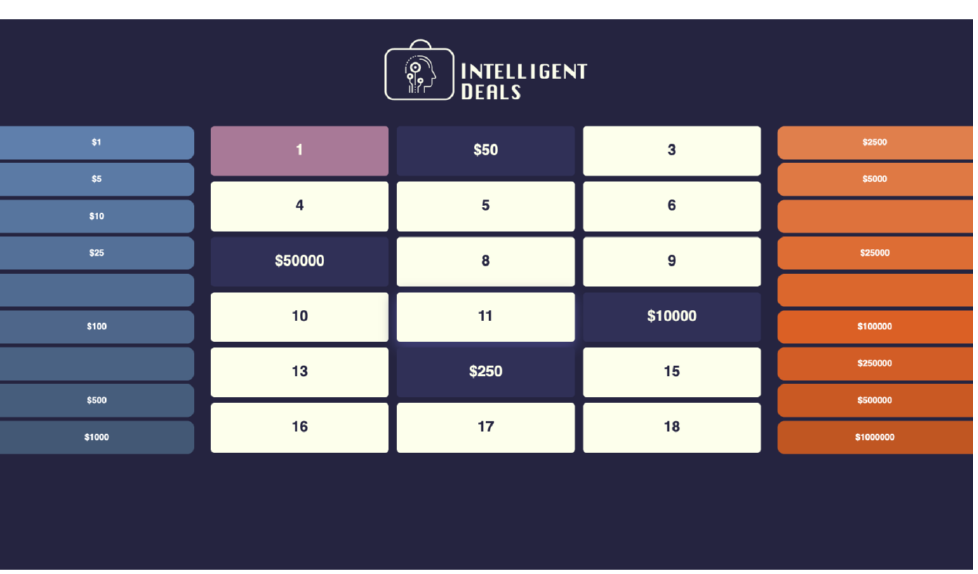
Figure 2. Task Surface. Several suitcases are already selected